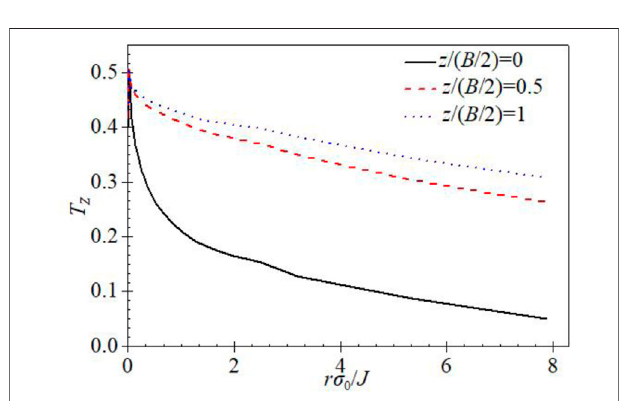
FIGURE8| T z aheadofthecracktipatdifferentthicknesslocation z fora CT specimen with B = 25 mm.